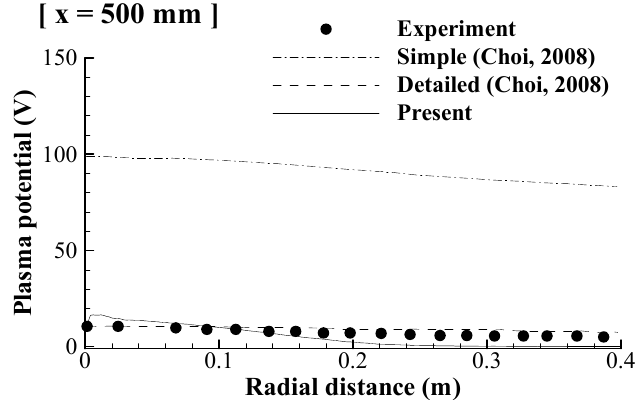
Figure 6. Radial profiles of the plasma potential for Case 2. Figures 7 and 8 compare the distributions of the ion current density and electron number density at x = 10 mm with experimental data. As shown in Figure 7, the ion current density in this study was in good agreement with the experimental data. In Figure 8, the electron number density in this study showed some discrepancies from the experimental data. In particular, the result of this study showed a much lower density near the axis. The isothermal electron fluid model generally overestimates the local temperature and plasma potential at the axis; hence, it underestimates the electron density. However, the trend of the electron number density showing a relatively high value near x = 0.02 m was similar to the experimental